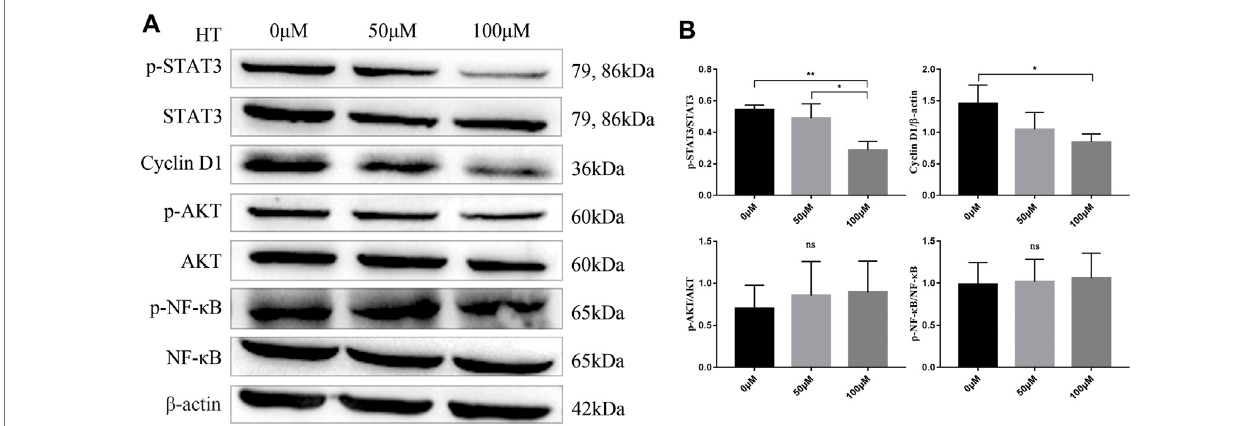
FIGURE2| HTinhibitsPanc02cellsproliferationbyinhibitingp-STAT3/CyclinD1signalingpathway.Panc02cellsweretreatedwithdifferentconcentrationsofHT for24 h,andtheexpressionofp-STAT3,STAT3,CyclinD1,p-AKT,AKT,p-NF-kB,NF-kB, β -actininthecellswasdetectedbywesternblot.Representativeimagesand relative expression of proteins (A,B) (* p < 0.05, ** p < 0.01). The analysis was based on three independent